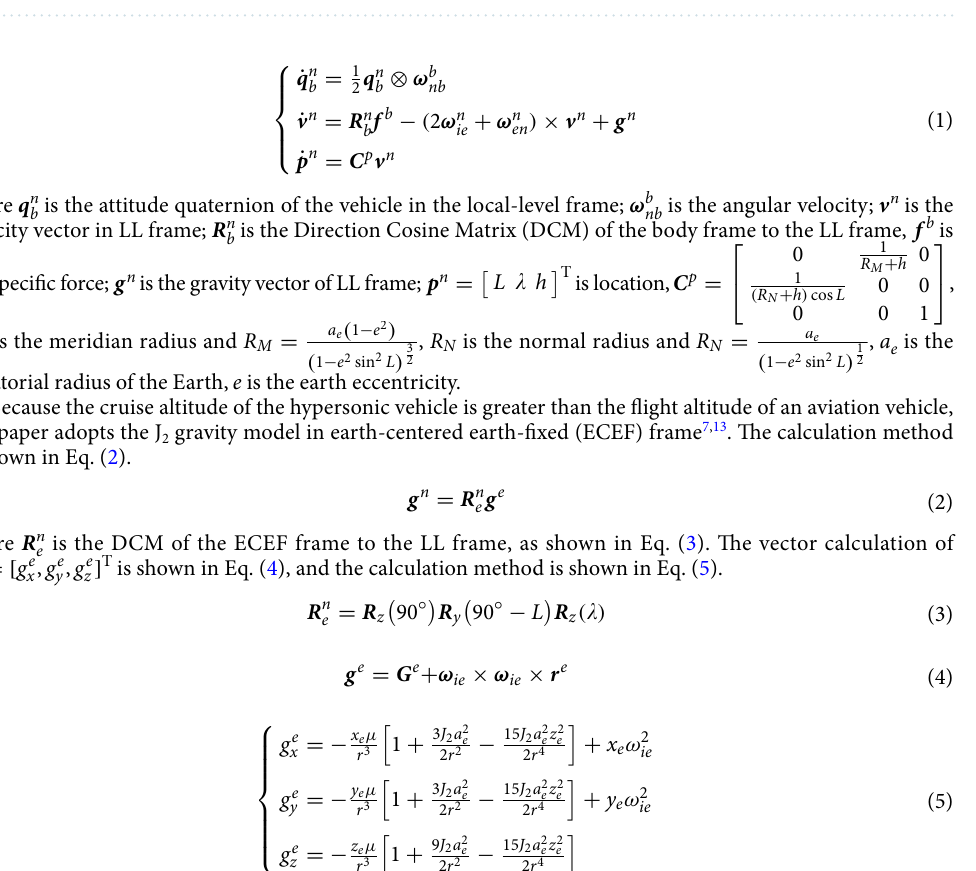
Figure 4. The data flow schematic diagram of the TCINS